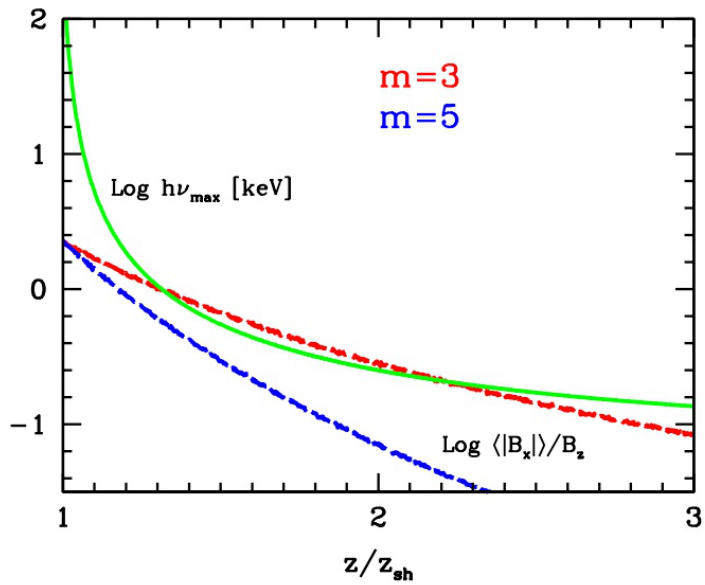
Figure 4. The spatial profiles of the ratio between the averaged perpendicular component of the magnetic field projected onto the plane of the sky and the parallel magnetic field component as a function of the distance from the shock front for the model that si assumed in [33,54]. The profiles correspond to m = 3 (red) and m = 5 (blue). The solid curve shows the maximum synchrotron photon energy (in the observer frame) as a function of the distance from the shock front. The synchrotron radiation in the X-ray range ( h ν max > 1 keV) is produced in the region where the field is dominated by the component parallel to the shock front, causing a large degree of polarization. From [33]. Reproduced with kind permission from Oxford University Press and the Royal Astronomical